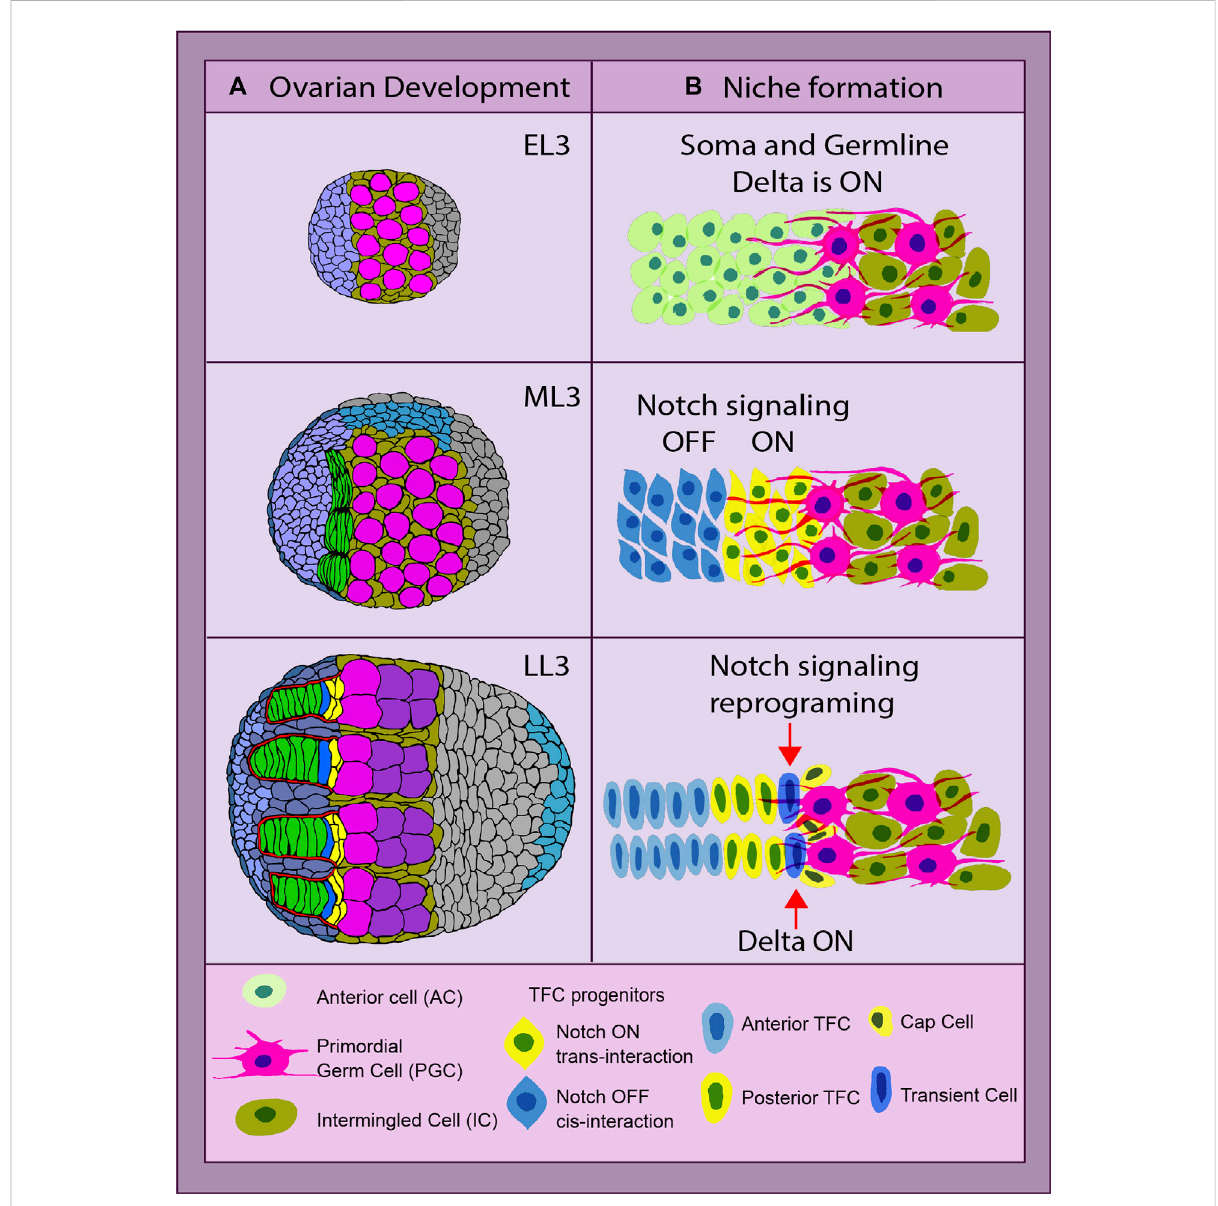
FIGURE 2 Drosophila ovariandevelopmentandnicheformation. (A) depictsanoverview ofovarianorganogenesisthroughouttheearly L3(EL3)stagetolateL3 (LL3),whichisthelastonebeforemetamorphosisensues.Thetransitionattheorganlevelfromaballoflargelyundifferentiatedcellstoahighlycomplexand organizedstructure,withthestemcellnicheconsistingoftheterminal fi laments(TFs)(green)paralleltoeachotherandadjacentcapcells(CpCs)(yellow).The primordialgermcells(PGCs)andgermlinestemcells(GSCs)aredepictedinpink(YatsenkoandShcherbata,2018). (B) showsthekeystepsofthestem cellnicheestablishment.Theanteriorsomaticcells(ACs,lightgreen)areTFcellprecursors.TheanteriorACshaveNotchsignalinginhibited viacis- or trans- inhibition (blue), while the posterior ACs receive a Delta signal via the germline protrusions and become Notch activated (yellow). These two parallel mechanismsofNotchsignalingstatusacquisitionsecurethe fi rststepofthestemcellnicheassembly — TFformation.Lateron,themostposterioroftheTFC in the stalk (TC, dark blue) experiences a reprogramming of its Notch signal-receiving status, becoming a Delta-sending cell instead. With its new ability of sending the signal, it recruits the second element of the niche, the CpCs (yellow, dark nucleus), making it ready to host the stem cells. All yellow cells have Notch signaling ON, and blue cells have Notch signaling OFF (Yatsenko and Shcherbata,